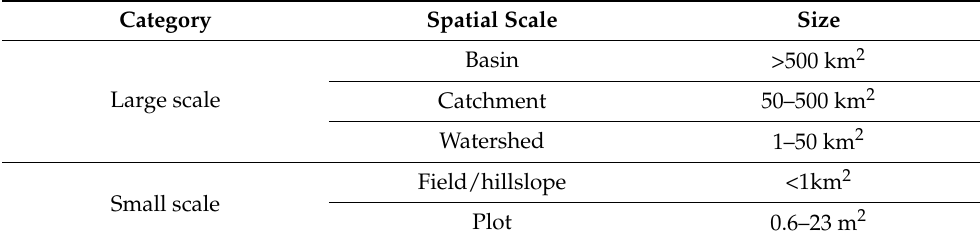
Table 2. Spatial scale sizes for soil erosion